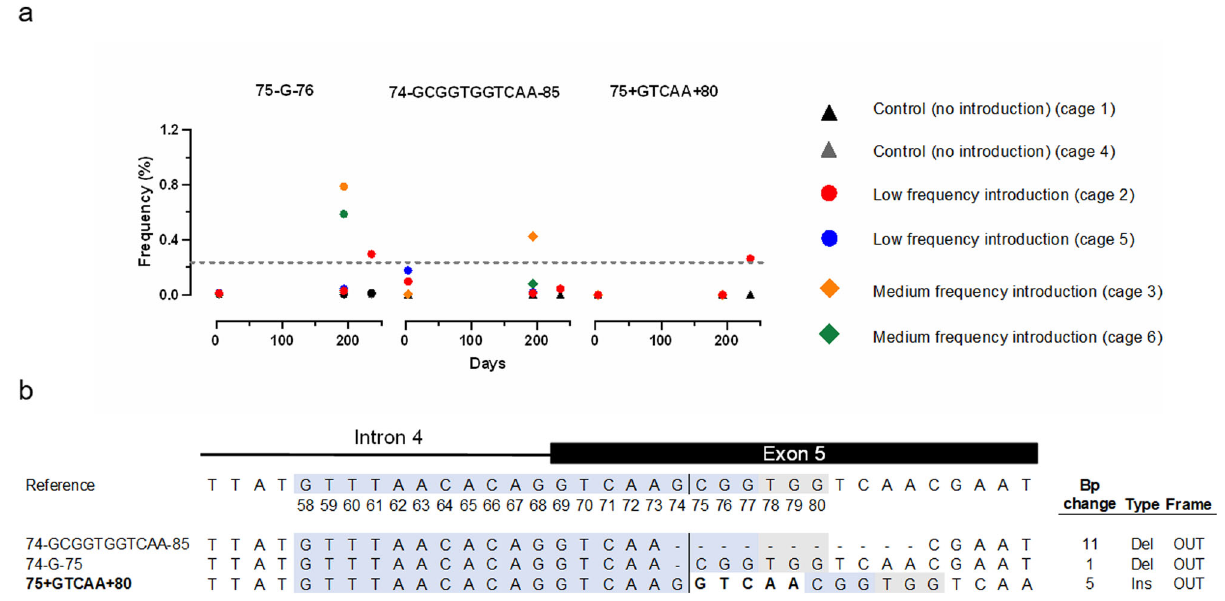
Fig. 3 Drive-resistant mutations do not come under positive selection as Ag(QFS)1 spreads in age-structured mosquito populations. a The % frequency of three putative non-restorative resistant alleles (R2) (75-G-76, 74-GCGGTGGTCAA-85, and 75 + GTCAA + 80) detected above the threshold frequency of 0.25% (Pfeiffer et al. 20 ), in at least one cage at a single point in time, amongst all non-drive alleles, is shown over time. Samples were taken on days 4 and 193 for all cages, and on day 235 where the number of mosquitoes exceeded the re-stocking requirement. The naming of each mutation indicates the base pairs inserted ( + ) or deleted ( − ), and its location relative to the Cas9/gRNA cleavage site between position 74 and 75, depicted in ( b ). Low gene-drive frequency introduction cages 2 and 5 were initiated at a maximum Ag(QFS)1 allelic frequency of 12.5%, whilst medium frequency introduction cages 3 and 6 were initiated at 25%. Wild-type control cages 1 and 4 did not contain Ag(QFS)1. b The position of the three R2 alleles detected is shown, and compared to the reference An. coluzzii and An. gambiae sequence of the intron4/exon 5 junction of the doublesex gene. Highlighted nucleotides indicate the gRNA binding site (blue) and PAM sequence (grey). Inserted nucleotides are shown in bold. The number of base pairs inserted or deleted and the effect on the resulting allele (in-frame (IN), or out-of-frame (OUT)) is shown to the right. Source: Dataset